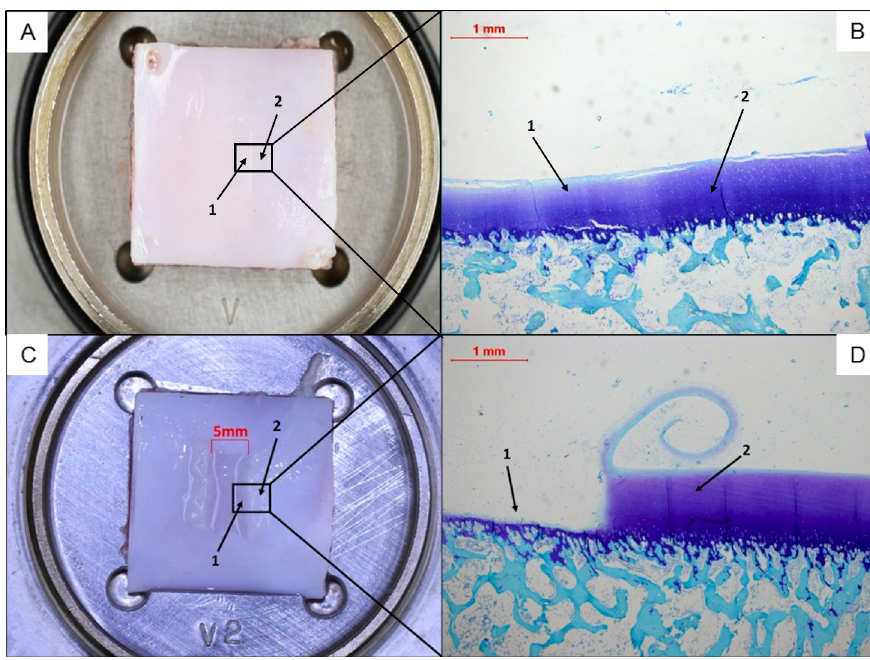
Fig 10. Representative images of the cartilage surface from a plate specimen of an old pig after tribological exposure, macroscopically (A) and histologically (B) in the cross section of the area where the pin moved. (1) indicates the track of the pin and (2) the control area. On slides (C) and (D) the same situation is shown for the plate specimen of a young pig. Here the track of the femoral pin with a diameter of 5 mm is clearly visible (1). The area directly next to it (2) served as the control area; this was not affected by the tribological exposure. (B) and (D) show the slides stained with toluidine blue. The superficial layer of the cartilage of the young pig was peeled off in a spiral shape (D).